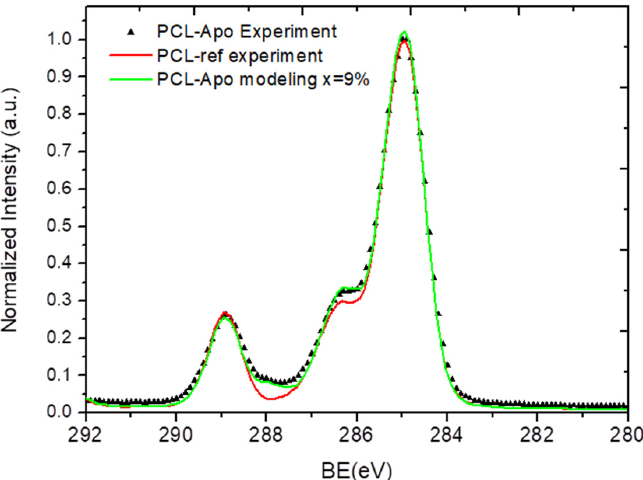
Figure 5. A comparison of the XPS C1s spectra: the experimentally measured PCL-Apo (PCL-Apo-Experiment), PCL-ref, and calculated PCL-Apo (PCL-Apo-modeling).